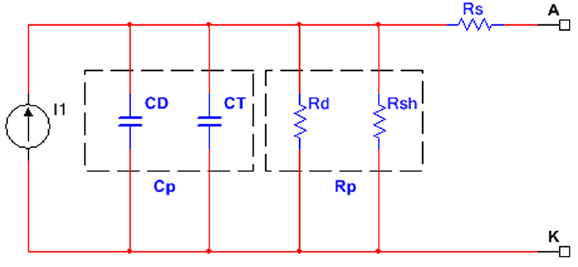
Figure 2. The AC equivalent electrical circuit of a solar cell.